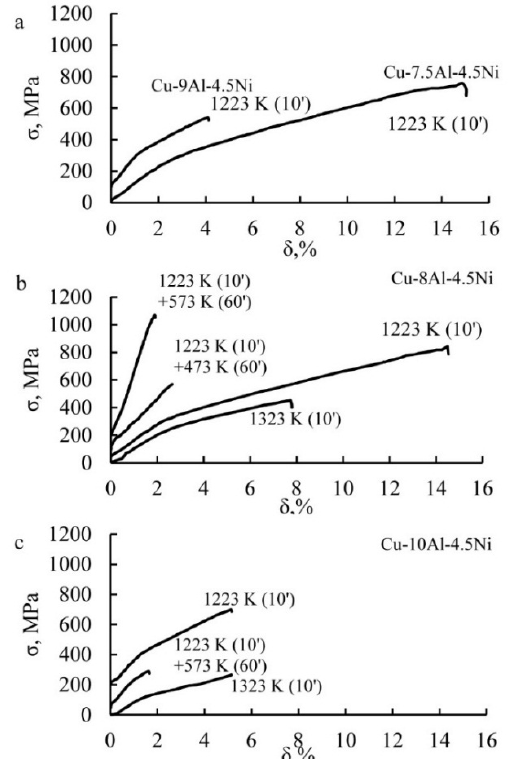
Table 3. Data of chemical X-ray microanalysis of the ( A ) Cu-13 wt.%Al-3 wt.%Ni after quenching from 1223 К , 10 min in water and ( B ) Cu-14 wt.%Al-3 wt.%Ni after quenching from 1223 К , 10 min in water and repeated quenching from 1273 K, 30 min in water at RT.